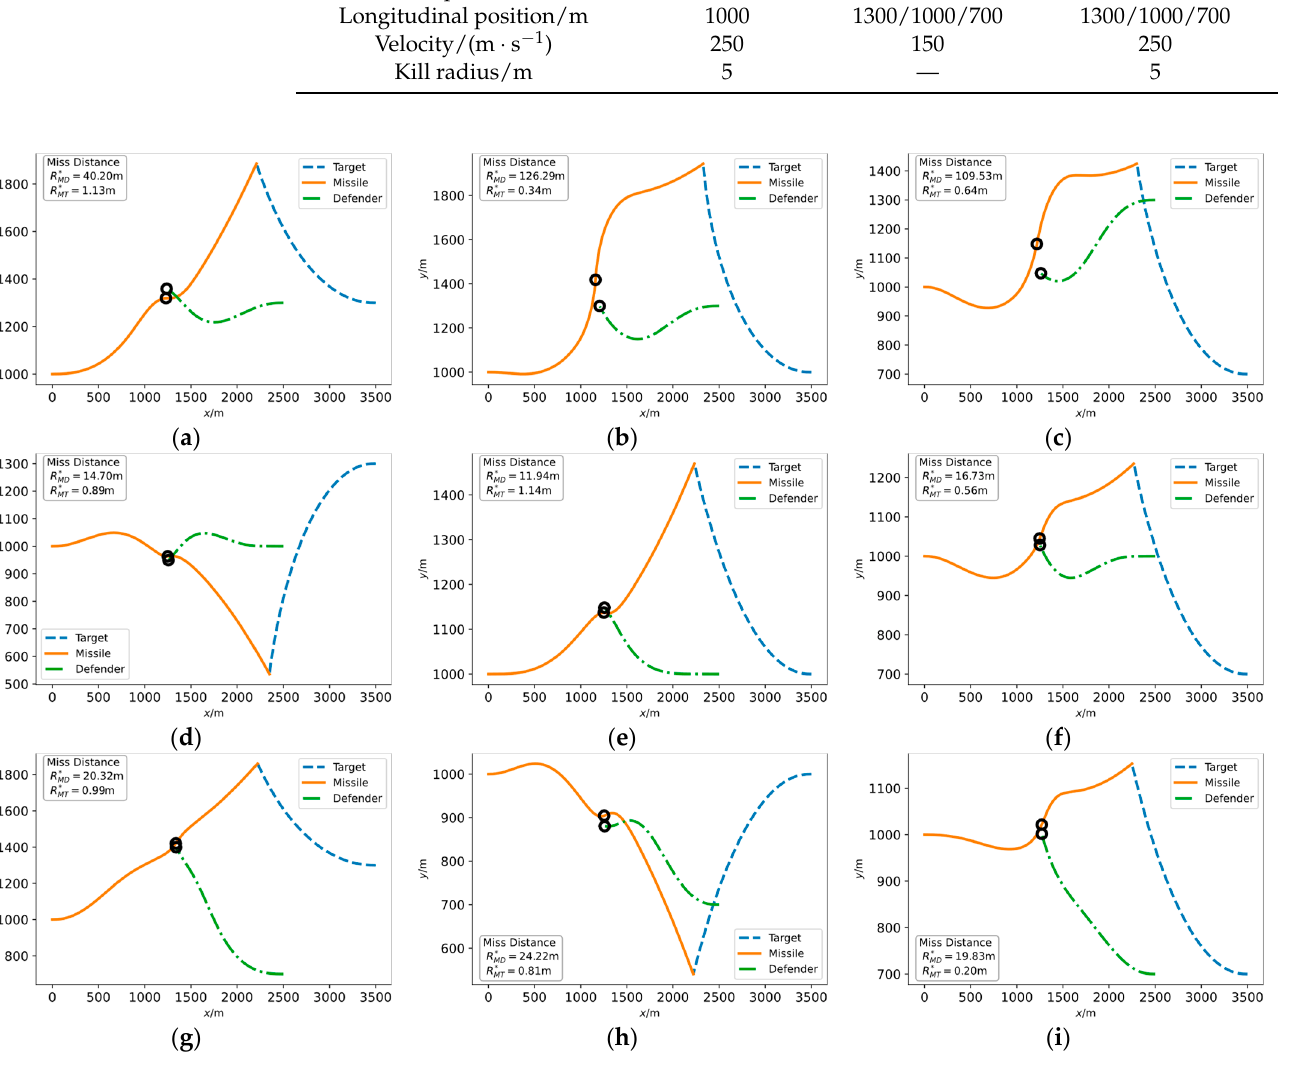
Figure 5. Engagement trajectories of assessing missile agent under different simulation